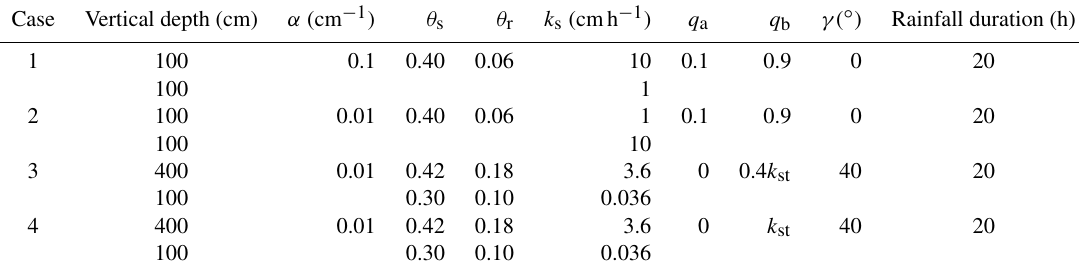
Table 1. Parameters used in the infiltration module verification.